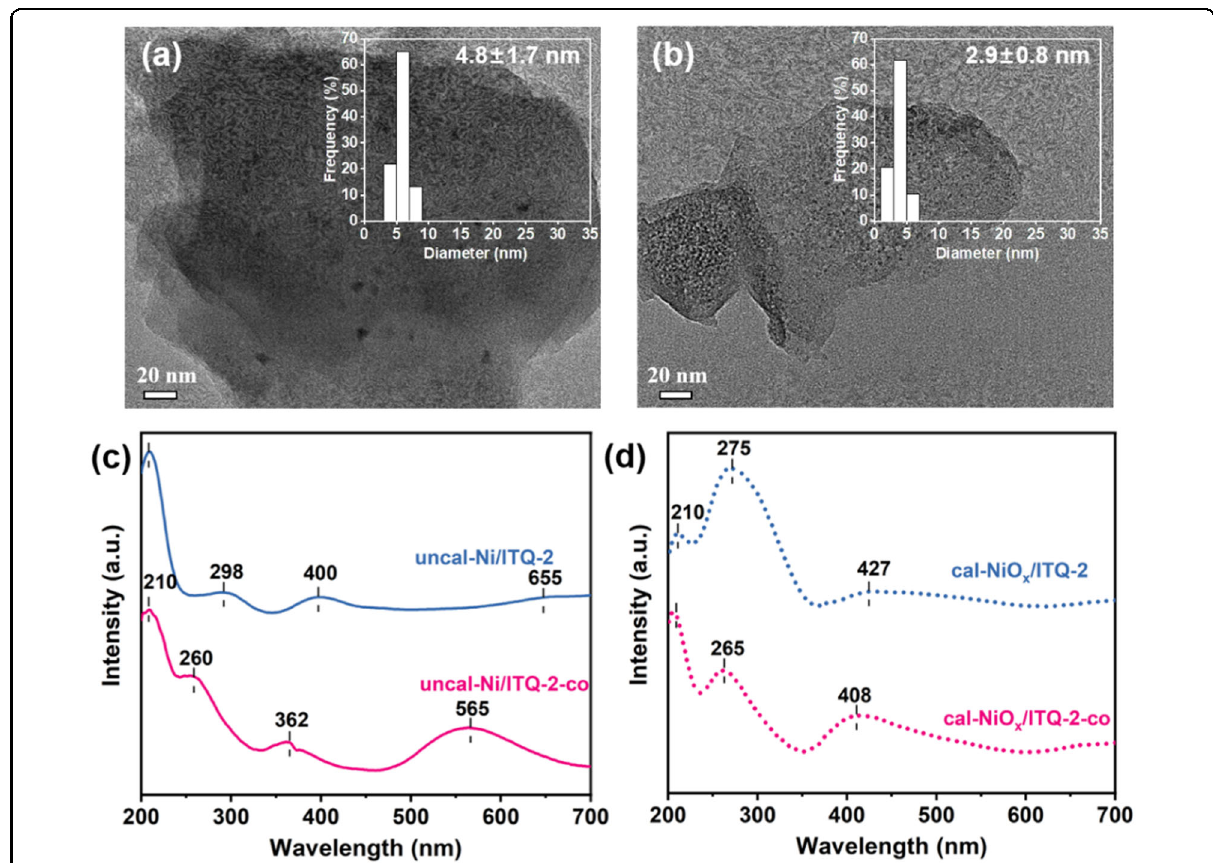
Fig. 3 TEM images and UV − Vis spectra of prepared samples. TEM images of the calcined NiO x /ITQ-2 ( a ) and NiO x /ITQ-2-co ( b ); UV − Vis spectra of the uncalcined Ni/ITQ-2 and Ni/ITQ-2-co showed with solid lines ( c ) and the calcined Ni/ITQ-2 and Ni/ITQ-2-co showed with dotted lines ( d